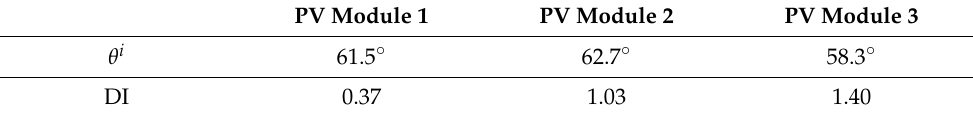
Table 1. Module orientation and DI (situation in which there is not a fault in the trackers).